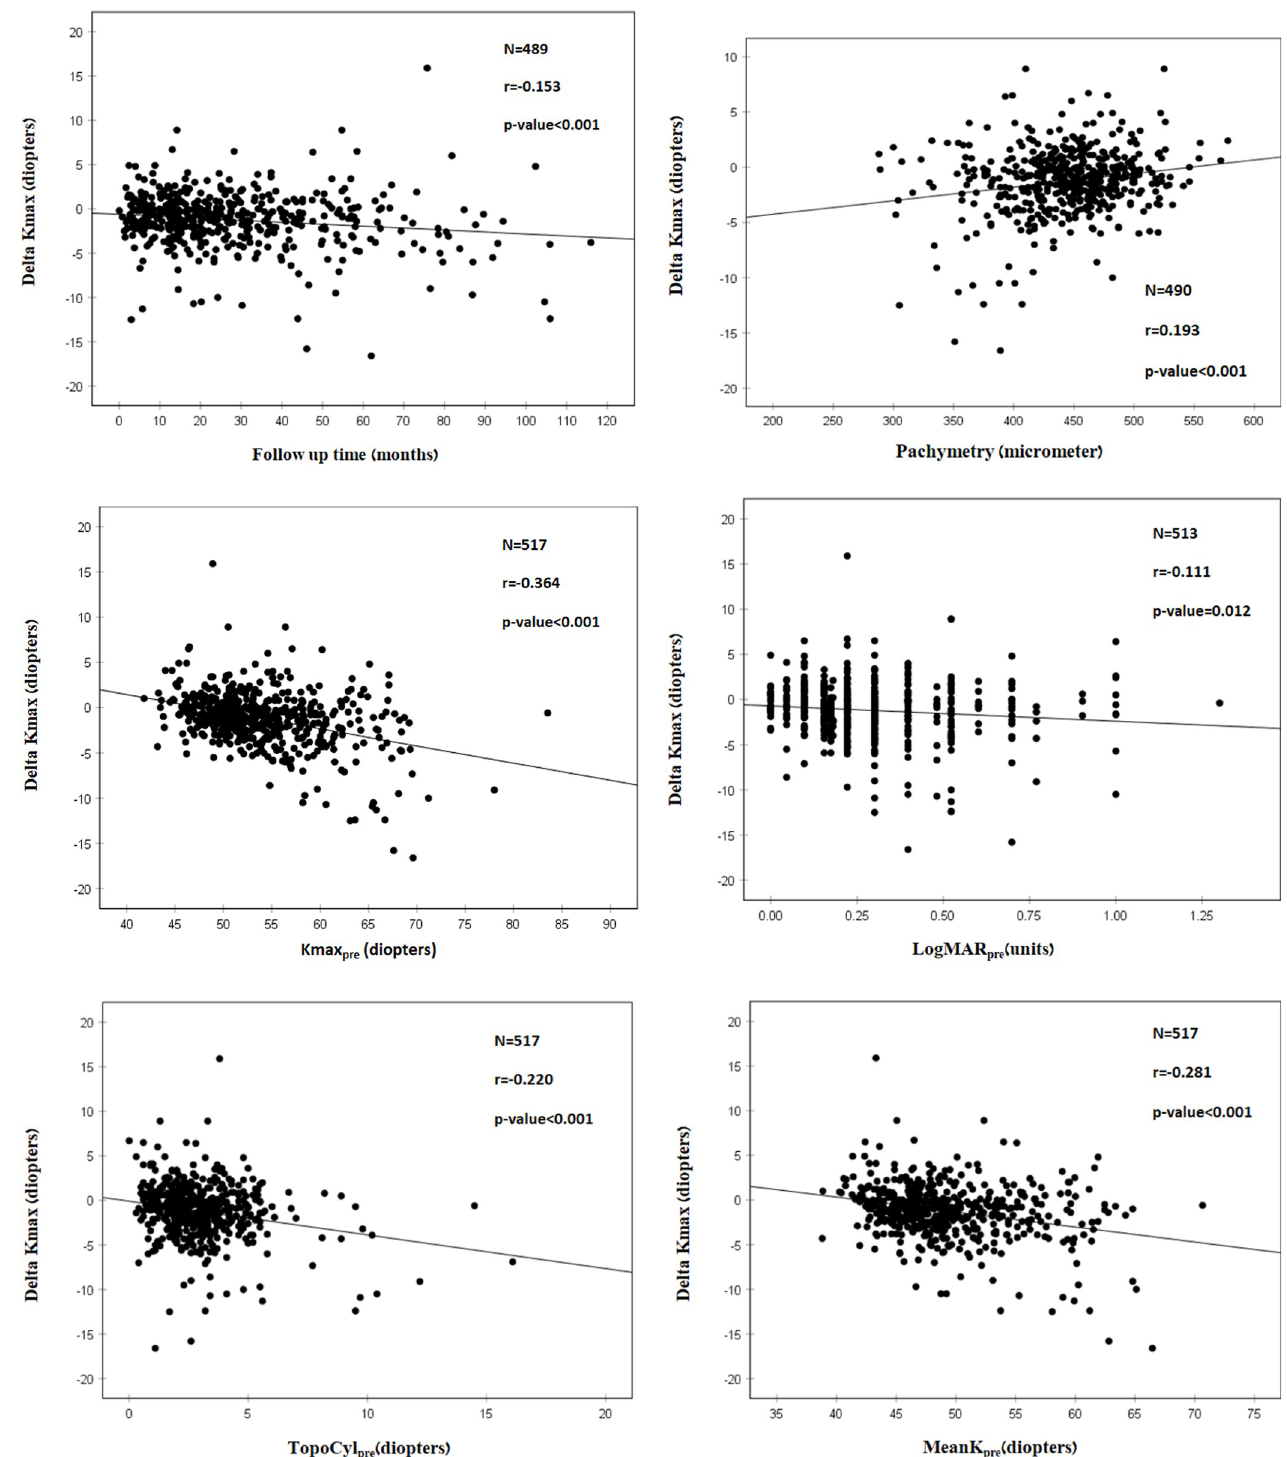
Fig 1. A. Correlation between follow-up time and Delta Kmax 1 . More negative Delta Kmax values were correlated with longer follow-up times, indicating the treatment effect was greater with longer follow-up times. However, the correlation coefficient is low, with r 2 = -0.153. Thus, although the correlation is significant, it is relatively weak. 1 Delta Kmax = (maximal corneal power after cross-linking)–(maximal corneal power before cross-linking). 2 r = Pearson correlation coefficient. B. Correlation between corneal thickness (pachymetry) and Delta Kmax 1 . More negative Delta Kmax values were significantly correlated with thinner corneas. This indicates that a thinner cornea can predict a better treatment outcome. However, the correlation coefficient is low, with r 2